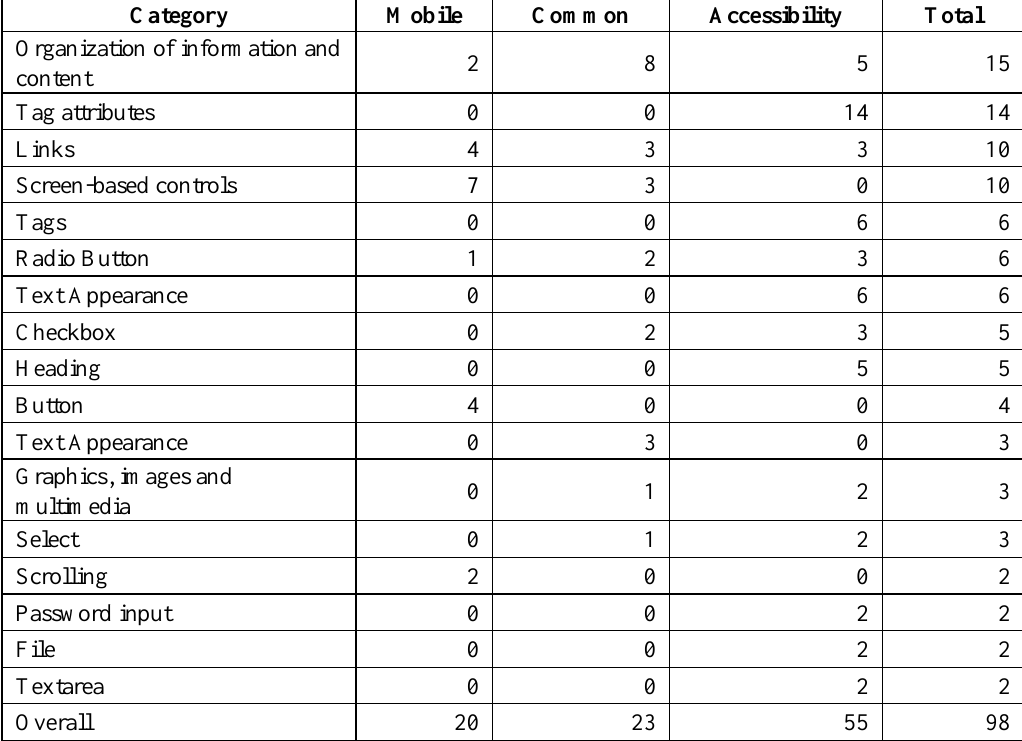
Table 2. Categories of usability guidelines for the established usability